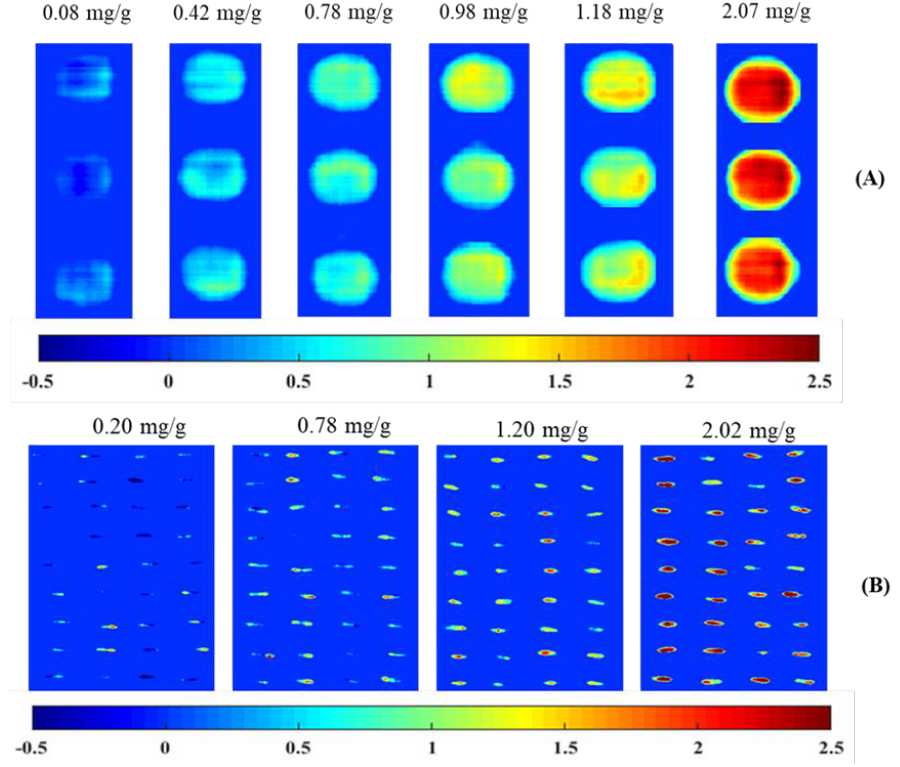
Figure 4. A visualization of anthocyanins based on their concentration in rice powder ( A ) and seeds ( B ).